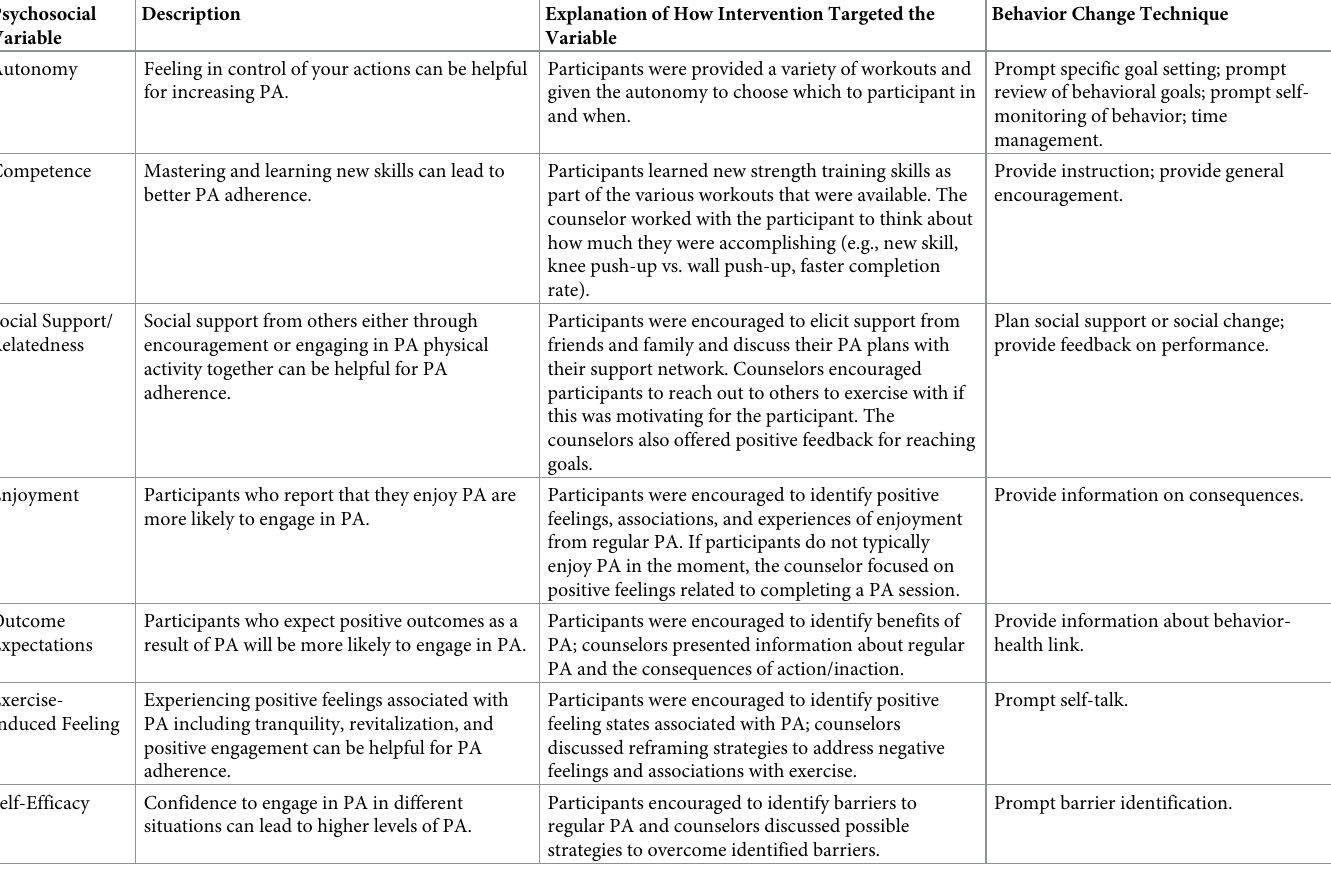
Table 1. Summary of intervention component targeting psychosocial